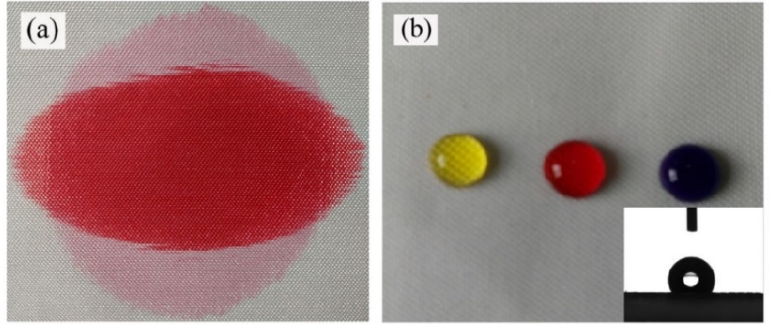
Figure 7. ( a ) Colored water droplet on pristine PET fabric; ( b ) PDMS/SiO 2 -PET fabric after four times blade coating (Reproduced from [42], with kind permission of Elsevier).